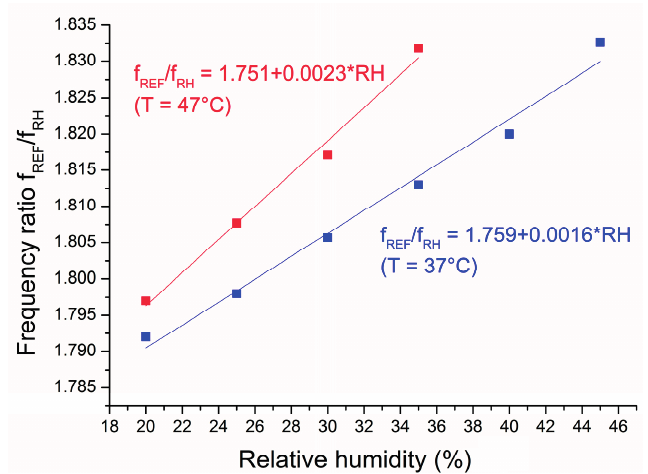
Figure 11. Measurement of frequency ratios in Version